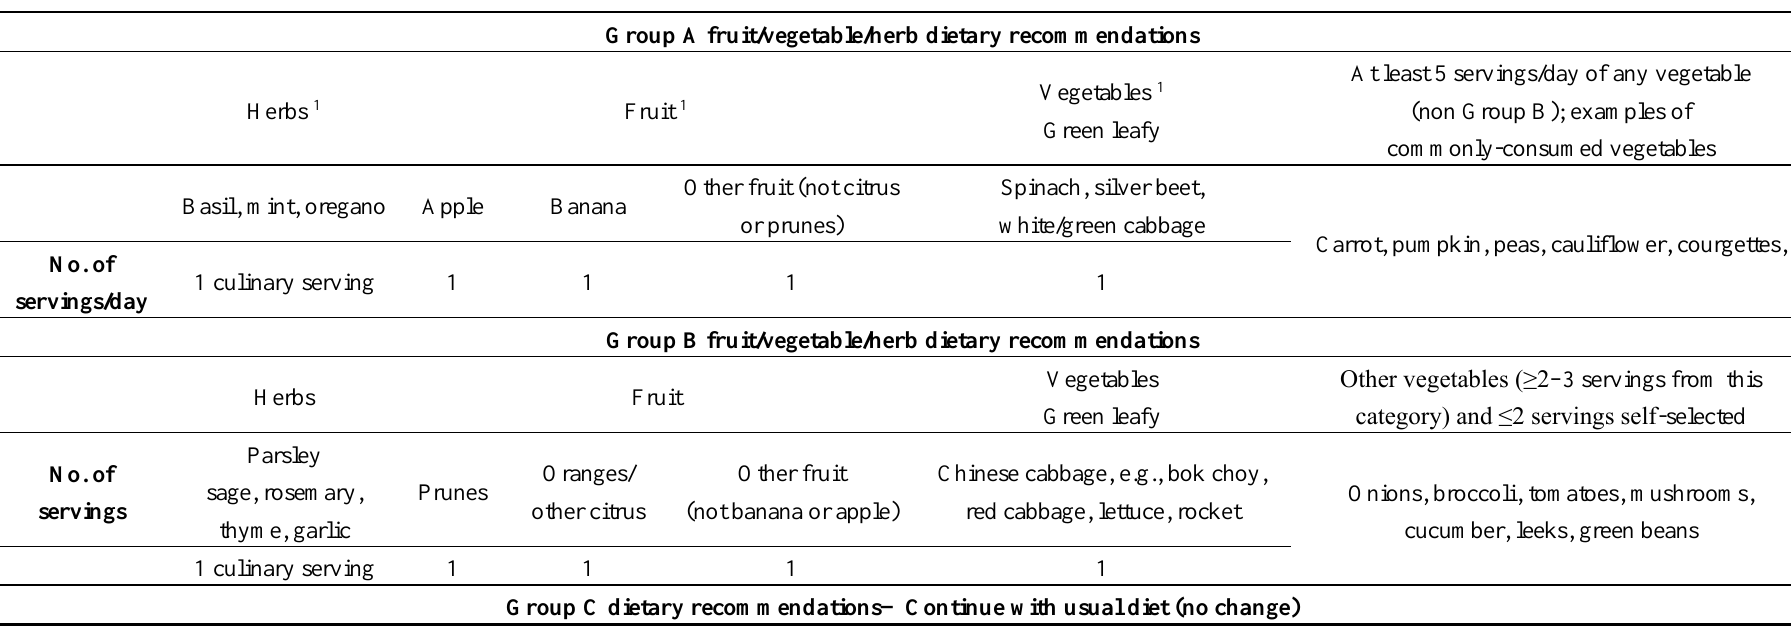
Table 1. Intervention and control group